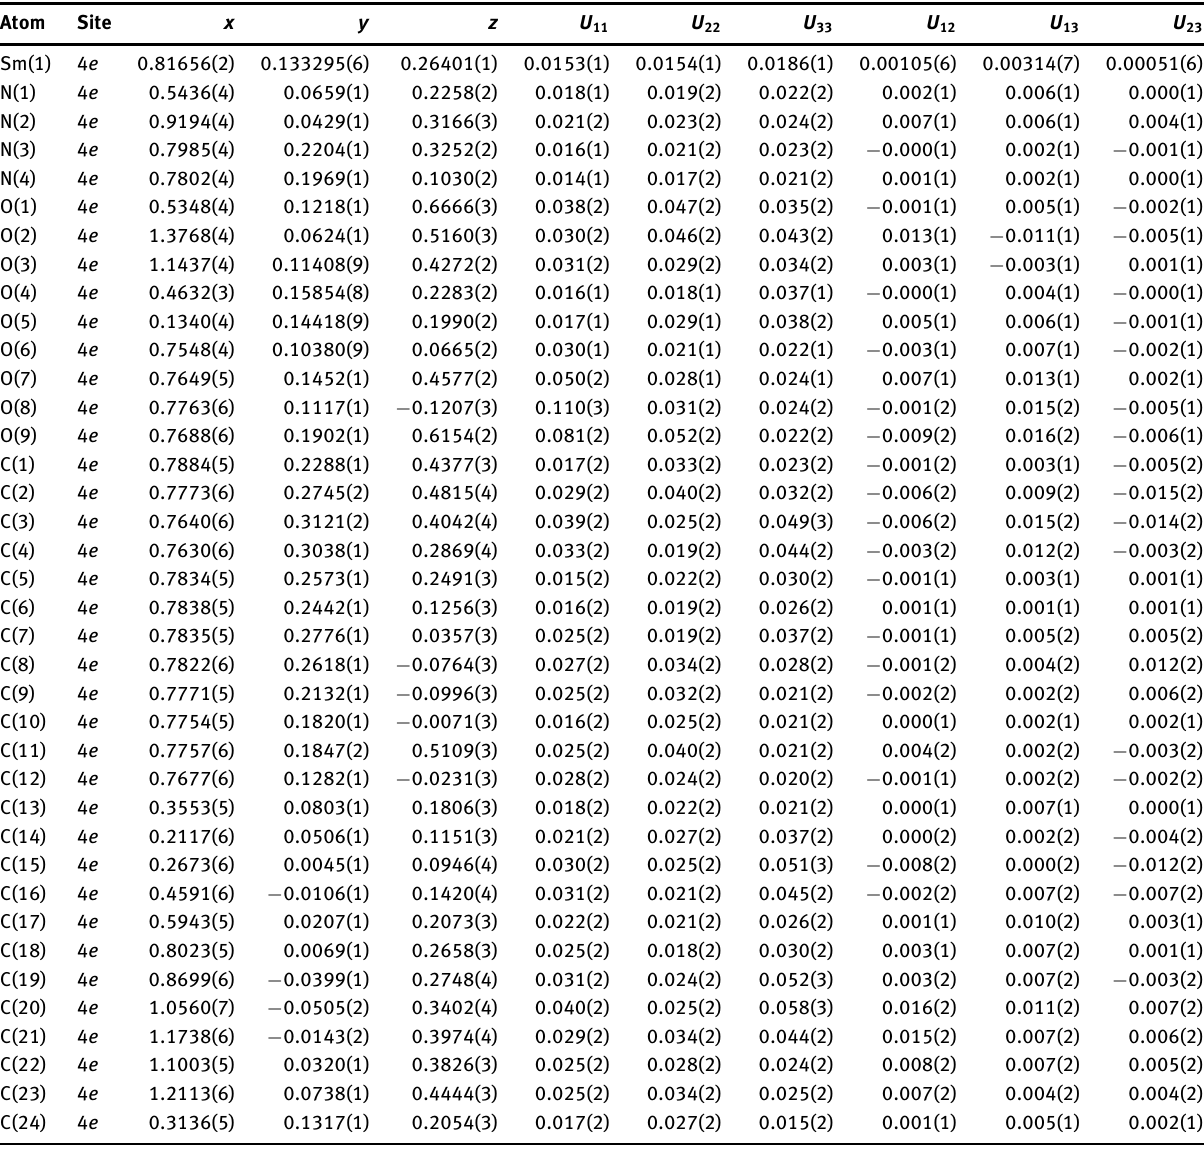
Table 3: Atomic displacement parameters (Å 2